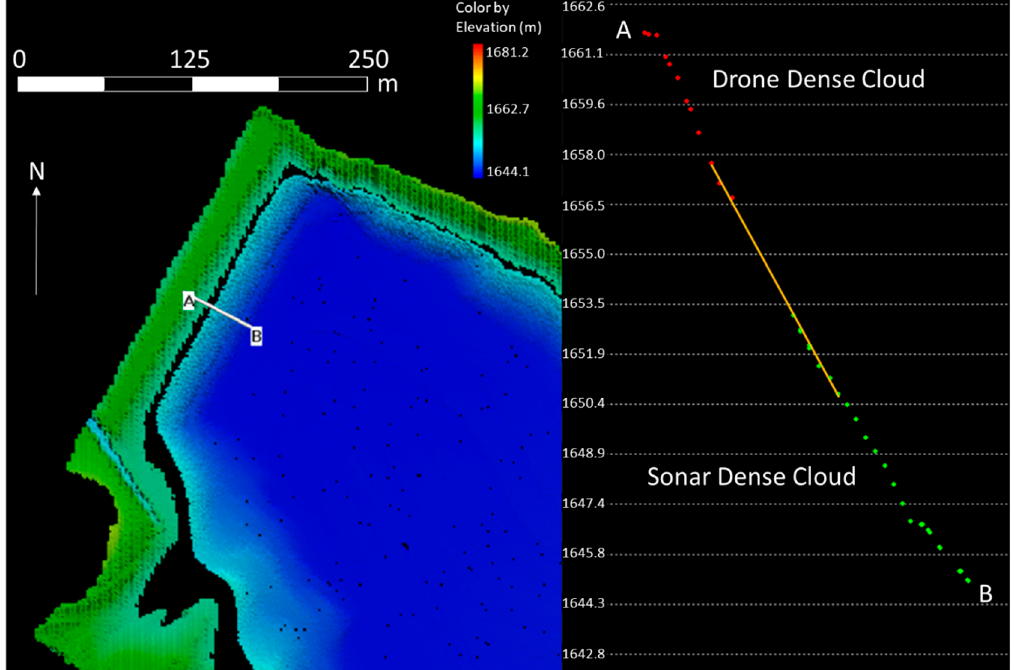
Figure 12. The line A–B in the left panel indicates the location of the cross-sections shown in the right panel and shows the points from the sonar and sUAV models at Newcastle Dam. The cross-section represents the data after the sonar model was translated to align with the sUAV model. The orange line represents the gap between the two models that will be filled by interpolation. This cross-section shows how the slopes generally line up between the models.